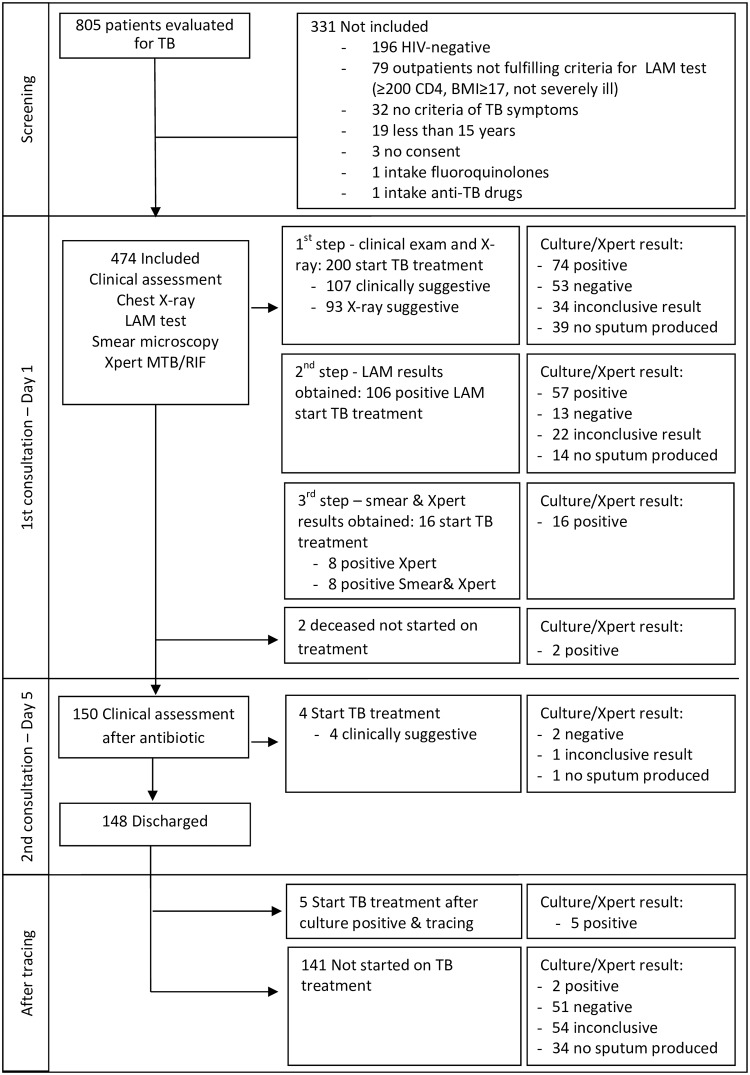
Diagnostic and treatment pathway of 474 patients with TB symptoms.